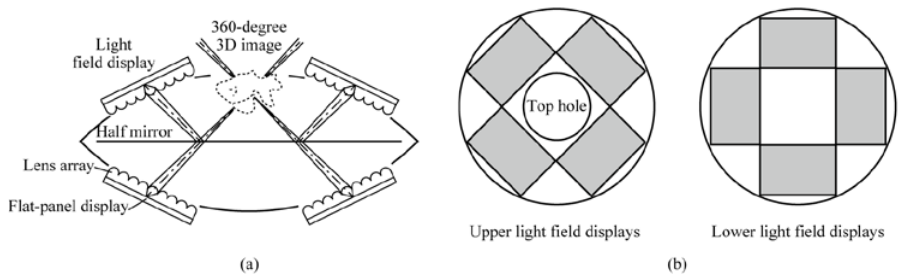
Figure 1. Schematic of light field Mirage: ( a ) side view and ( b ) top view.